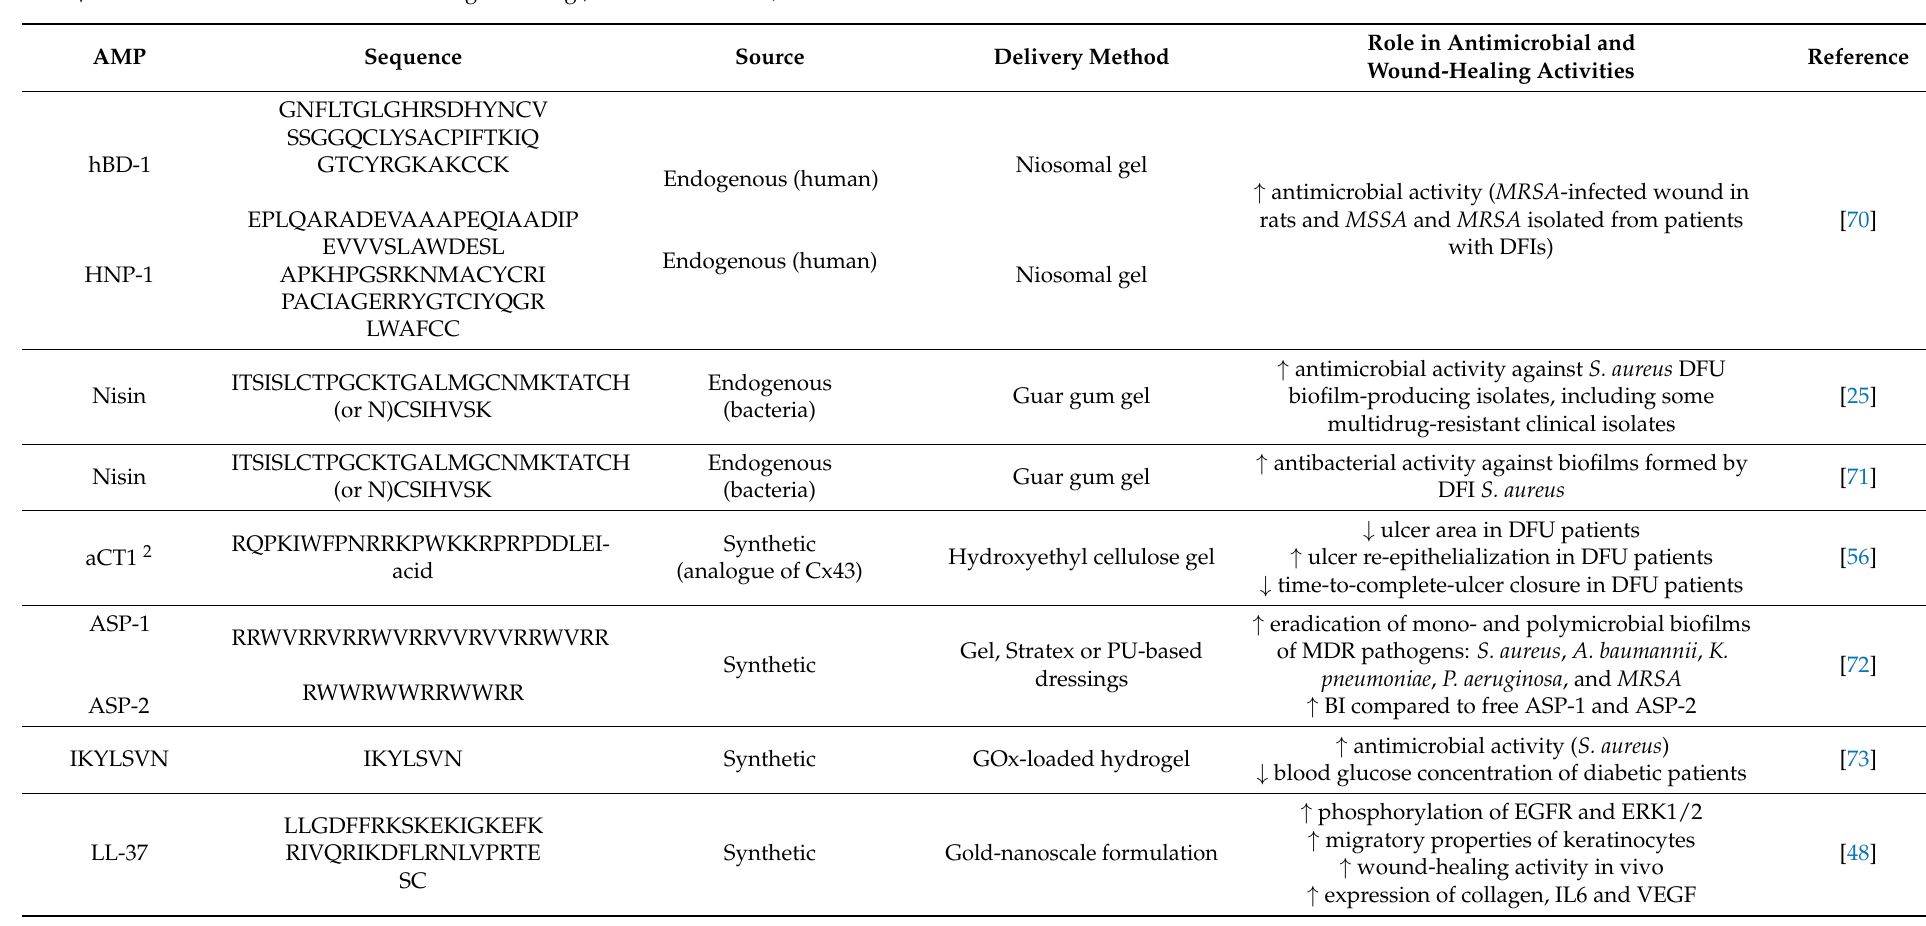
Table 4. AMPs loaded on delivery systems being applied as promising therapies for infected chronic wounds and their respective roles in antimicrobial and wound-healing activities. All AMPs are presented according to the following criteria: (1) loaded on a delivery system vs. chemically modified and loaded on a delivery system; (2) endogenous vs. synthetic; and (3) alphabetic order. AMP sequences are presented using the one-letter amino acid code, as per the IUPAC-IUBMB Joint Commission on Biochemical Nomenclature rules. ↑ —increase; ↓ —decrease. 1 AMPs that were tested against fungi; 2 AMPs that were/are under clinical